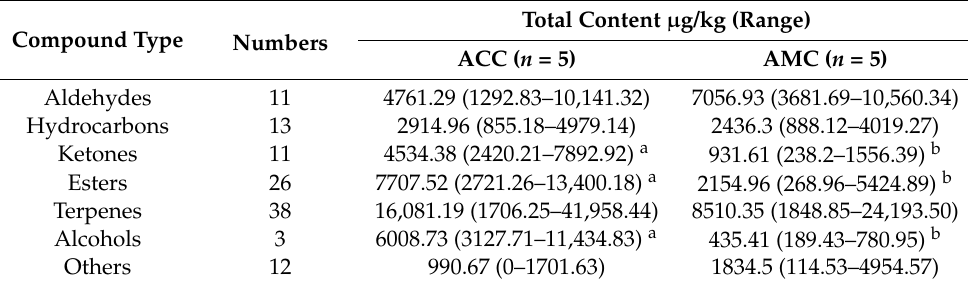
Figure 1. Typical chromatogram of the volatile components from ACC ( A ) and AMC ( B ) by SPME- GC–MS. Table 1. Compound type of ACC and AMC detected by